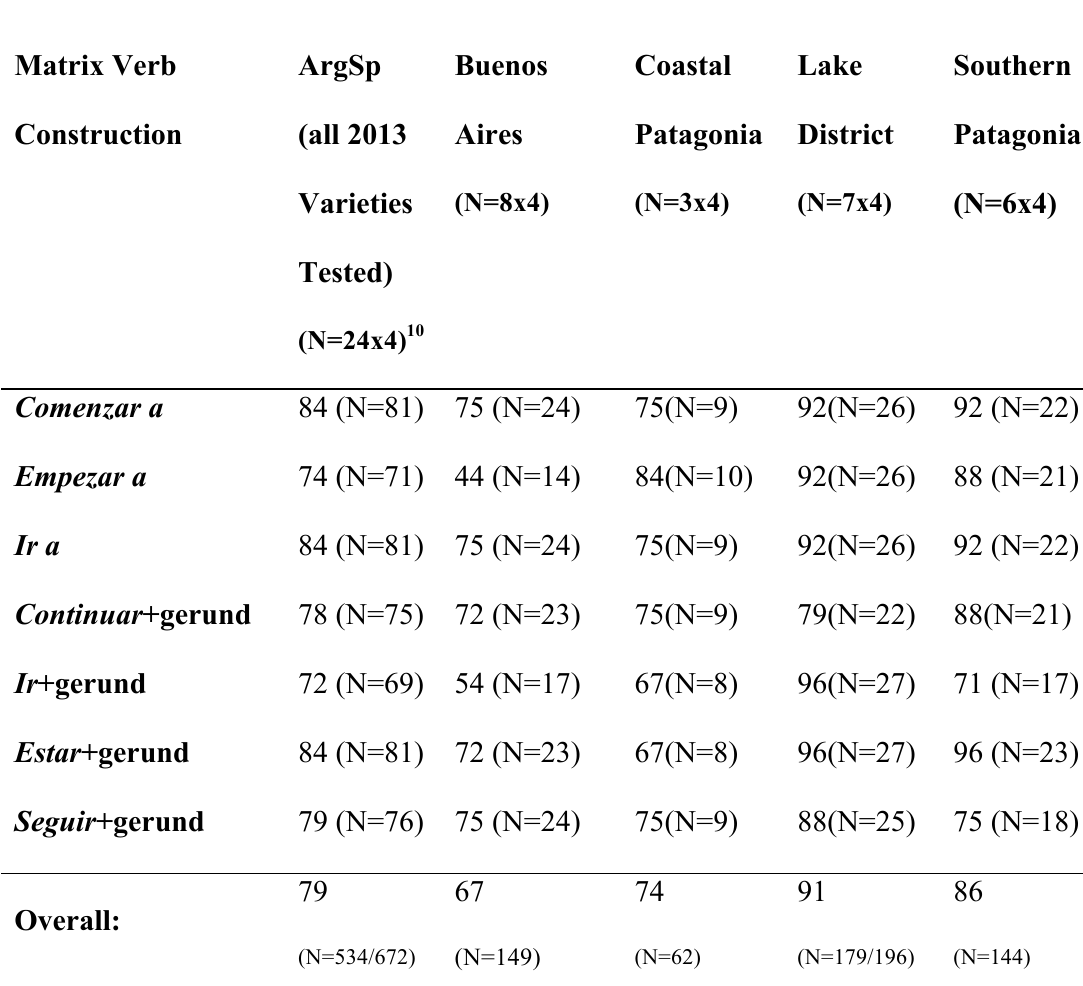
Table 7. Percentage of [+CC] acceptability to first degree of grammaticality in 2013 data by matrix verb and ArgSp